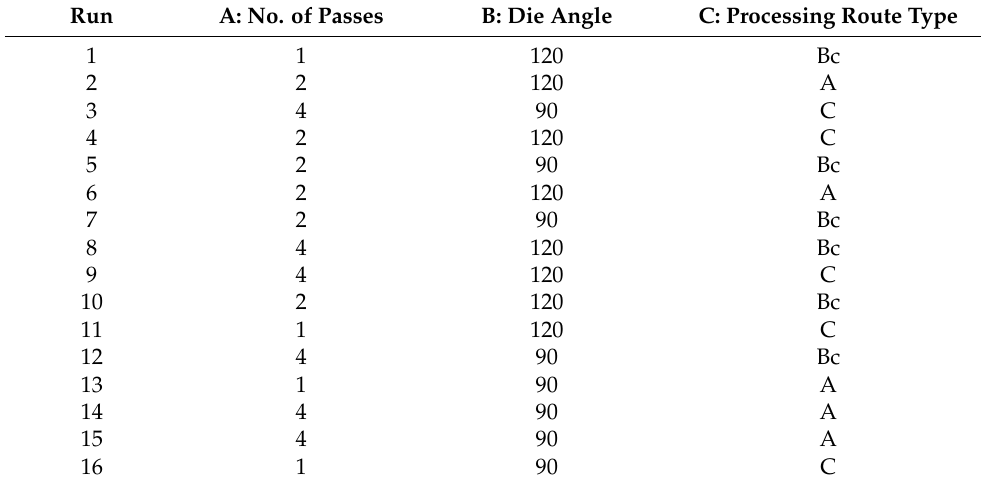
Table 2. Design of experiment of ECAP